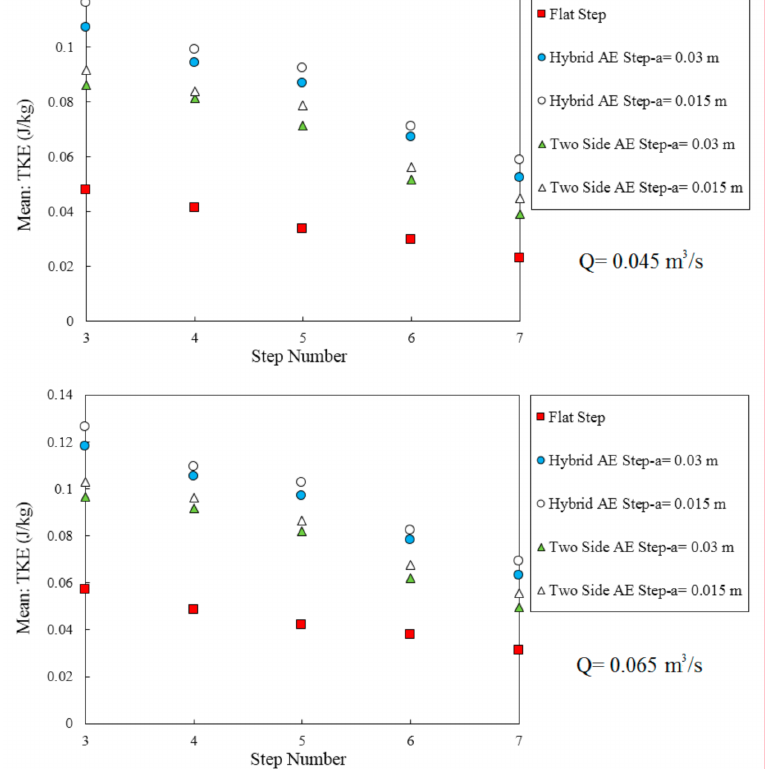
Figure 18. The mean TKE (J/kg) value on appendance elements step with different heights and dis-